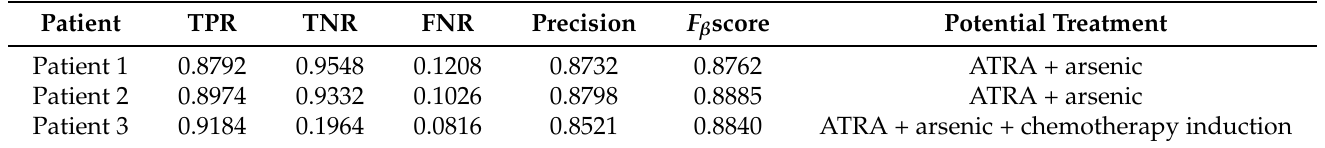
Table 13. The end-to-end diagnosis performance of three patients.